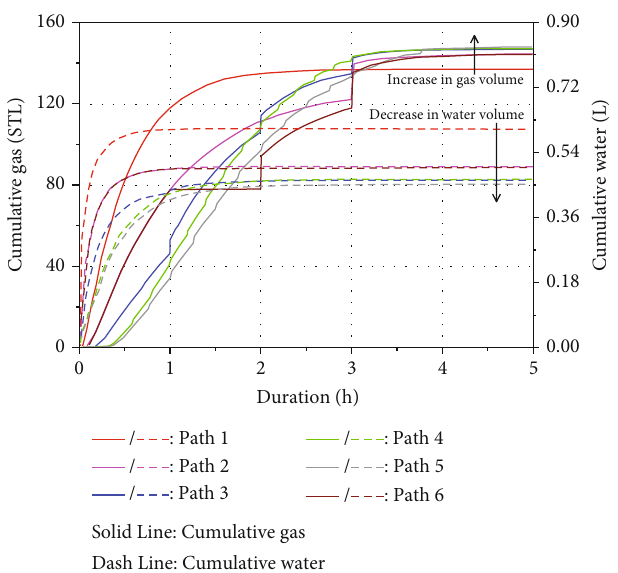
Figure 6: Evolutionary behaviors of cumulative gas and cumulative water under di ff erent depressurization modes. The initial hydrate saturation is 10% for all simulation cases in this fi